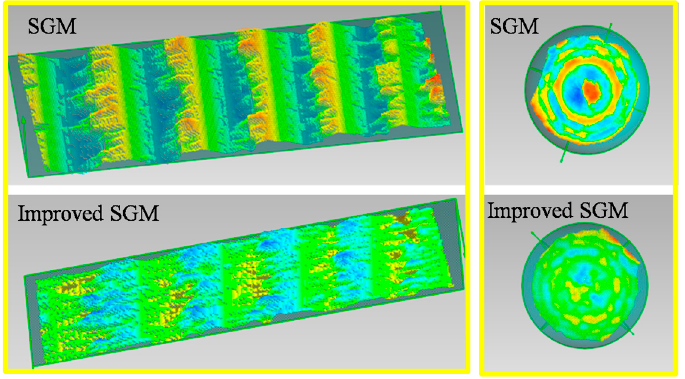
Figure 12. E ff ect comparison of SGM and improved Figure 12. Effect comparison of SGM and improved SGM. Figure 12. Effect comparison of SGM and improved SGM.